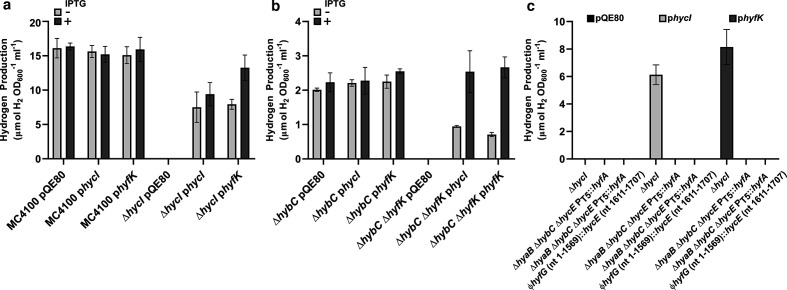

P. atrosepticum
 HyfK can activate
E. coli
 Hyd-3, and
E. coli
 HycI can activate
P. atrosepticum
 Hyd-4. (a)
E. coli
 strains MC4100 (FHL-1+) and MGE1dI (ΔhycI) were transformed separately with plasmids harbouring hycIEc, hyfKPba or a vector control (pQE80). Strains were grown anaerobically in LB medium supplemented with 0.2 % (w/v) formate, ampicillin and 1 mM IPTG where indicated (+) for 24 h at 37 °C. (b)
P. atrosepticum
 strains PH002 (ΔhybC, FHL-2+) and PH006 (ΔhybC, ΔhyfK) were transformed with plasmids containing hycIEc, hyfKPba or pQE80. Strains were grown anaerobically in low-salt LB (LSLB) medium supplemented with ampicillin and 1 mM IPTG where indicated (+) for 48 h at 24 °C. (c)
E. coli
 strains MGE1dI (ΔhycI), FTE003 (ΔhyaB, ΔhybC, ΔhycE, PT5::hyfA) and FTE004 (ΔhyaB, ΔhybC, ΔhycE, PT5::hyfA, ϕhyfG::hycE) were transformed with plasmids containing hycIEc, hyfKPba or a vector control (pQE80). Strains were grown anaerobically in LB medium supplemented with 0.8 % (w/v) glucose, ampicillin and 1 mM IPTG for 16 h at 37 °C. In all cases, H2 headspace samples were extracted and analysed by gas chromatography (Shimadzu GC2014 using a 5A molecular packed column with thermal conductivity detection). Data was normalized by OD600 and culture volume. Error bars represent sd (n=3).